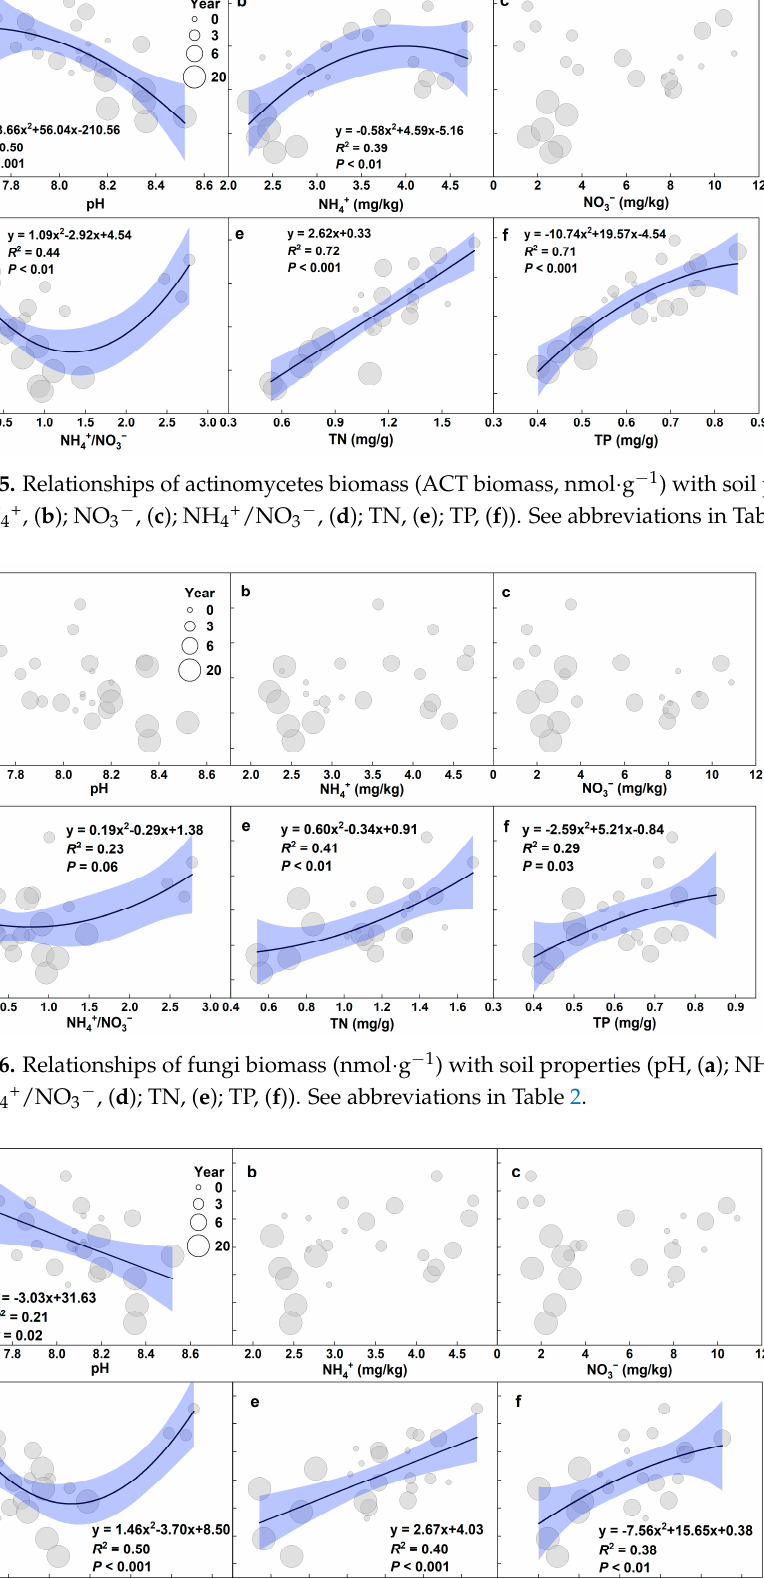
Figure 4. Relationships of bacteria biomass (nmol·g − 1 ) with soil properties (pH, ( a ); NH 4+ , ( b ); NO 3 − , ( c ); NH 4+ /NO 3 − , ( d ); TN, ( e ); TP, ( f )). See abbreviations in Table 2.